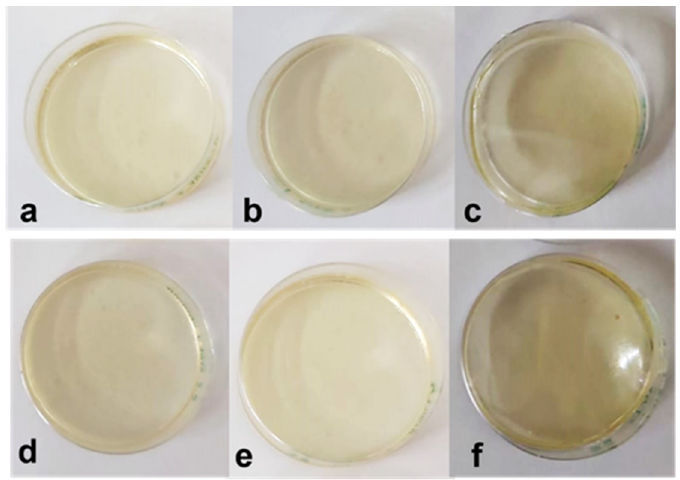
Figure 8. Images of the produced films, with non-loaded niosomes ( a – c ), with loaded niosomes ( d – f ), with neutral niosomes ( a , d ), with niosomes + CTAB ( b , e ), and with niosomes + SDS ( c , f ) .